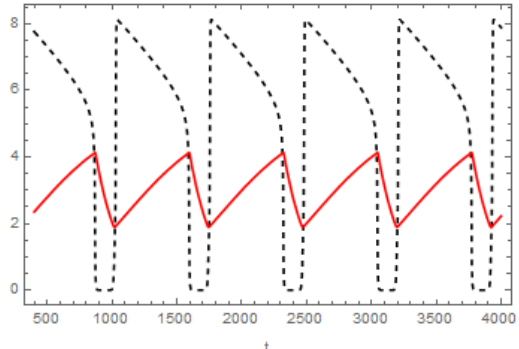
Figure 4. Time series of System (7) with the black dashed curve (prey) and red full curve